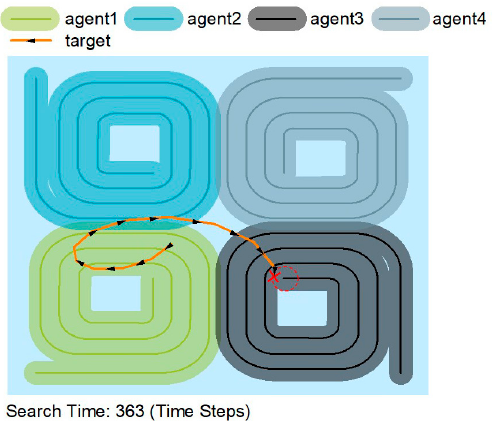
Figure 7. Search paths for the spiral search algorithm.